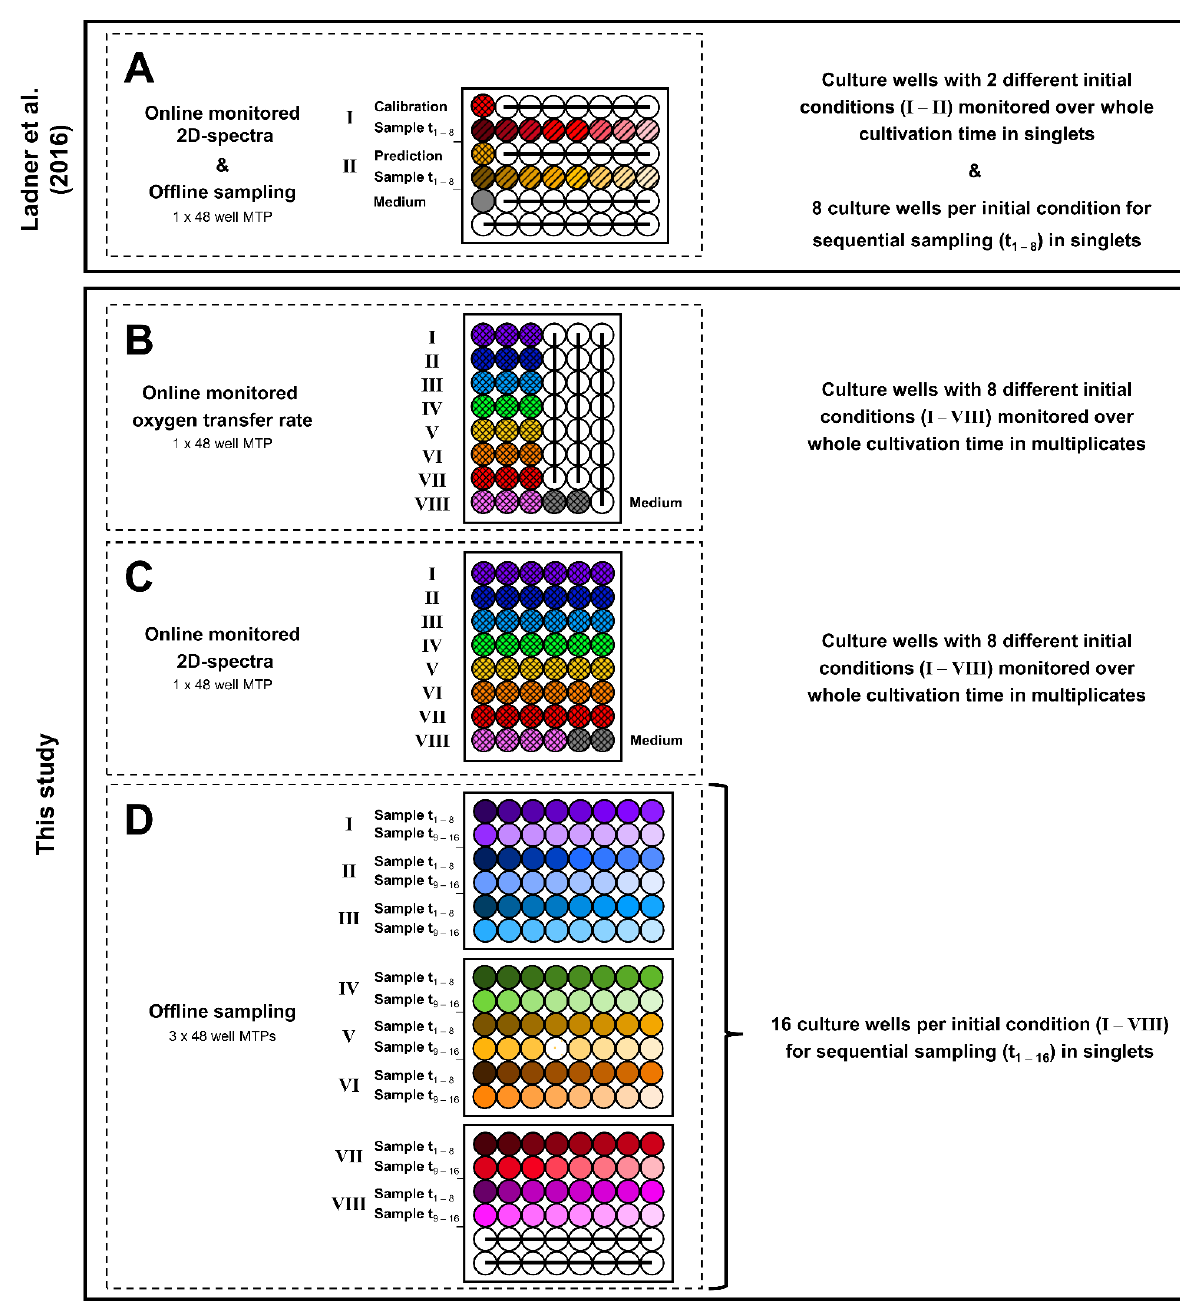
Figure 2. Comparison of experimental sampling strategies used in previous and current publication. The previous publication by Ladner et al. [45] included direct sampling from an MTP in the online-monitoring cultivation system, limiting both the amount of online data and offline samples ( A ). This study used multiple MTPs in parallel cultivation devices ( B – D ), indicated by dashed boxes. The metabolic activity in the form of the oxygen transfer rate (OTR) was measured in the µRAMOS cultivation system published by Flitsch et al. [49] ( B ). Recording of 2D spectra ( C ) and offline sam- pling ( D ) were conducted in two individual devices. Cross-hatched wells indicate cultures moni- tored over the whole cultivation time. Diagonal-hatched wells indicate monitored wells being sam- pled during cultivation. Unhatched wells indicate non-monitored wells used for sampling. Grey wells indicate wells with non-inoculated medium. White, struck-through wells were not used.